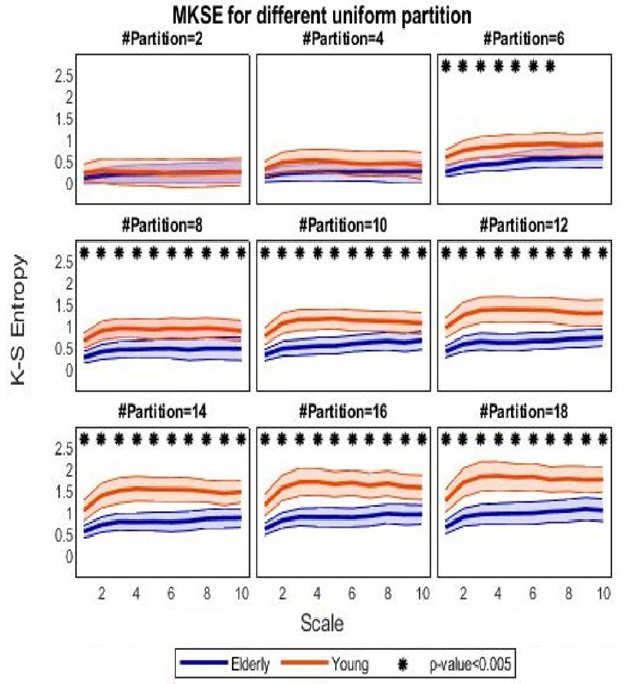
Figure 3. MKSE values for the two groups. Orange lines refer to MKSE values extracted in the young groups, whereas blue lines represent MKSE for the elderly ones. Thick lines indicate the median across subjects, whereas chromatic shaded areas represent the median absolute deviations. Each subfigure reports MKSE values (vertical axis) as a function of the time scaling τ (horizontal axis) for a different partition cardinality (even), increasing in the left-right and top-down directions from 2 to 18. Asterisks indicate corrected p -value < α = 0.005 from a nonparametric Mann–Whitney test for unpaired samples.